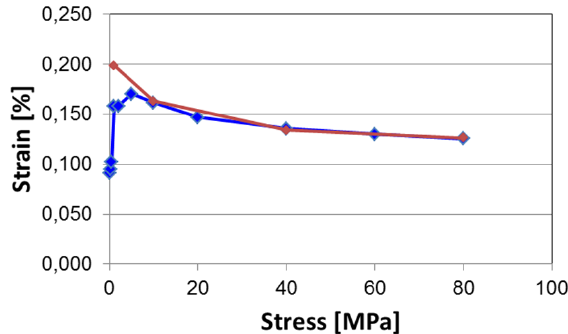
Figure 15. Effective strain of a stack actuator made of Nd ‐ doped BNT ‐ BKT ‐ BLT at various stress levels at 8 kV/mm (blue symbols: increasing stress, red symbols: decreasing stress).